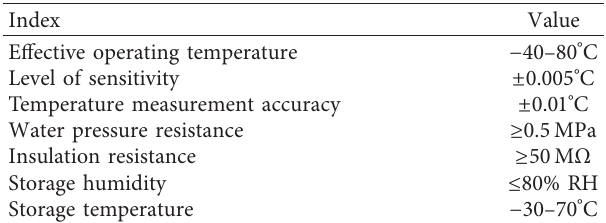
Figure 1: Schematic diagram of the working layout for the typical hydrostatic levelling system. Table 3: Technical parameters of the RT-1Q temperature